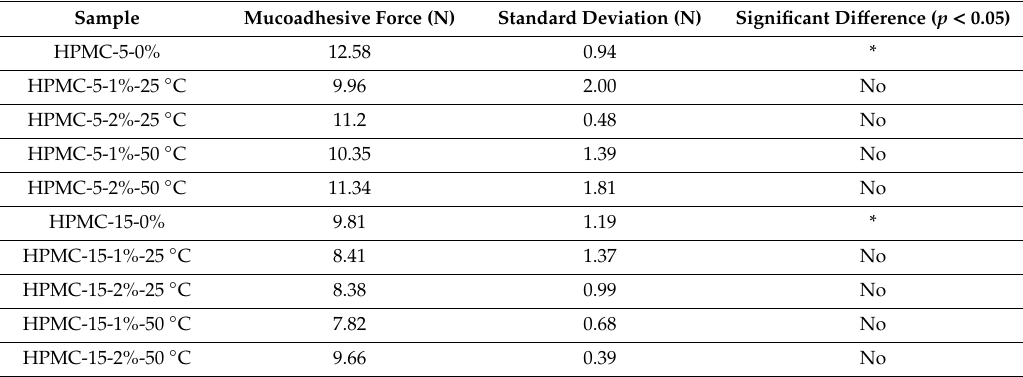
Table 4. The results of mucoadhesive force measurement. (*: reference value).